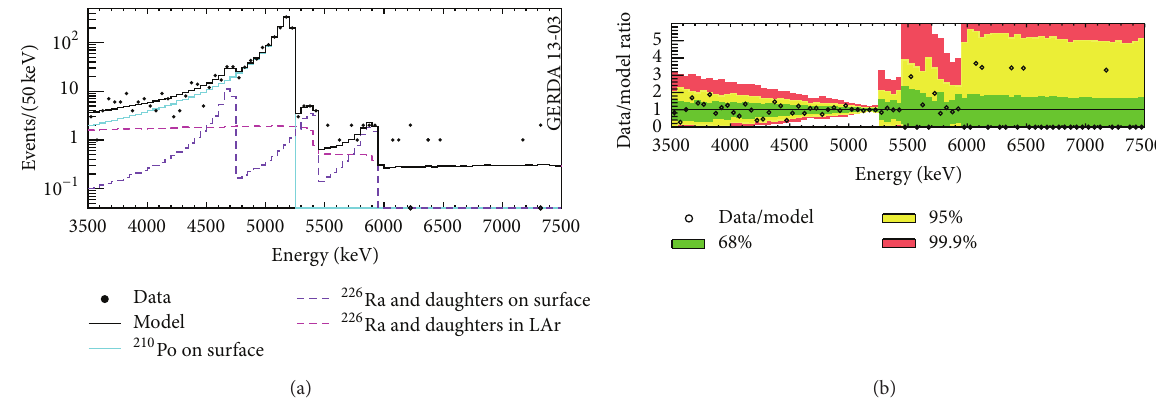
Figure 6: (a) shows the best fit model (black histogram) and the observed spectrum (black dots) for the 𝐺𝑂𝐿𝐷 - 𝑐𝑜𝑎𝑥 data set. The other curves represent the individual components of the model. (b) shows the data over model ratio (empty points) and the smallest intervals containing 68% (green), 95% (yellow), and 99.9% (red) probability for the model expectation. From